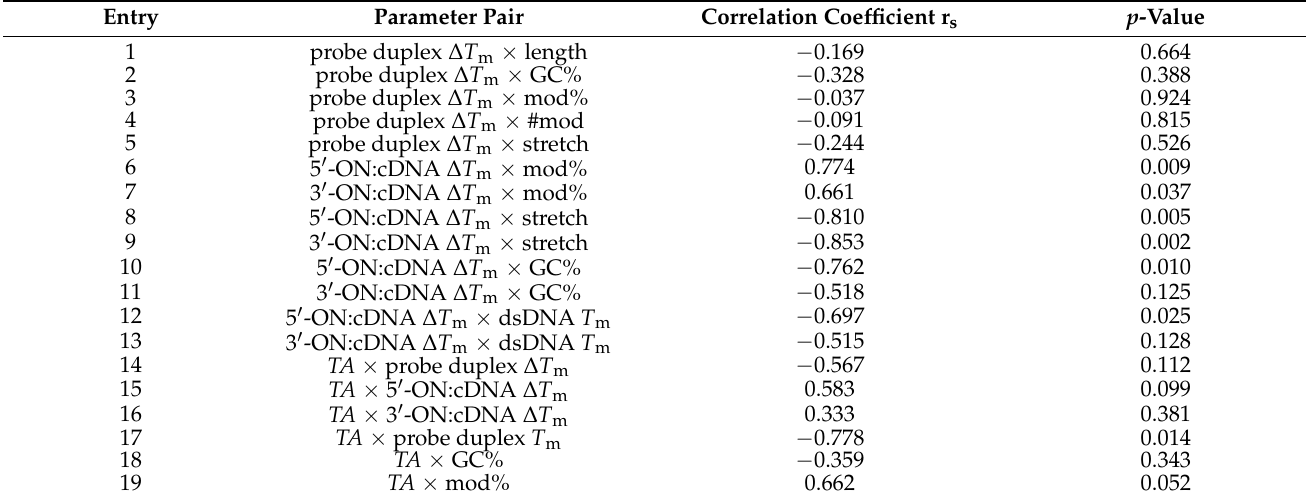
Table 2. Selected data pertaining to denaturation properties and dsDNA-recognition potential from Spearman’s rank-order correlation analysis of parameter pairs a